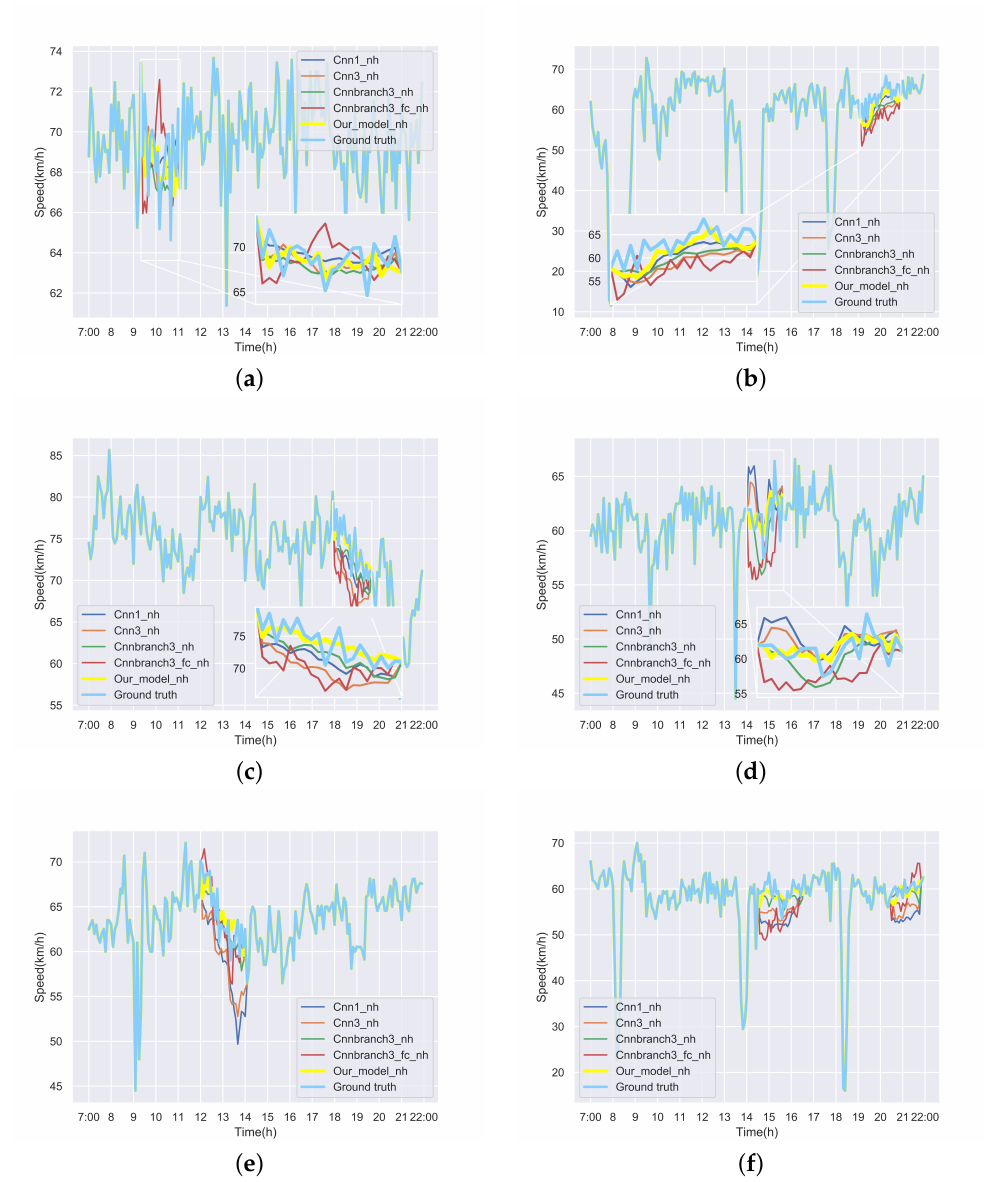
Figure 16. Repaired speed curves and corresponding ground truth of six loop detectors of Neihuan elevated highway. ( a ) The repaired values and the ground truth of the 7th loop detector on the Neihuan elevated highway in the 2nd test day. ( b ) The repaired values and the ground truth of the 24th loop detector on the Neihuan elevated highway in the 10th test day. ( c ) The repaired values and the ground truth of the 14th loop detector on the Neihuan elevated highway in the 12th test day. ( d ) The repaired values and the ground truth of the 10th loop detector on the Neihuan elevated highway in the 15th test day. ( e ) The repaired values and the ground truth of the 32nd loop detector on the Neihuan elevated highway in the 21st test day. ( f ) The repaired values and the ground truth of the 31st loop detector on the Neihuan elevated highway in the 27th test